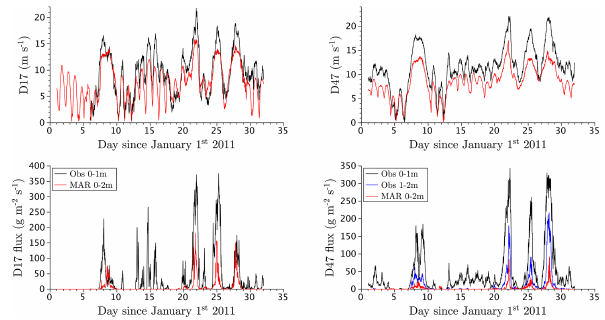
Figure 3. Top: observed (black) and simulated (red) wind speed at a height of 2m. Bottom: aeolian snow transport events: comparison of observed snow mass fluxes from 0 to 1m (black) and simulated fluxes from 0 to 2m (red) at the D17 site (bottom left) and at the D47 site (bottom right). Observed snow mass fluxes from 1 to 2m (blue) are also given for the D47